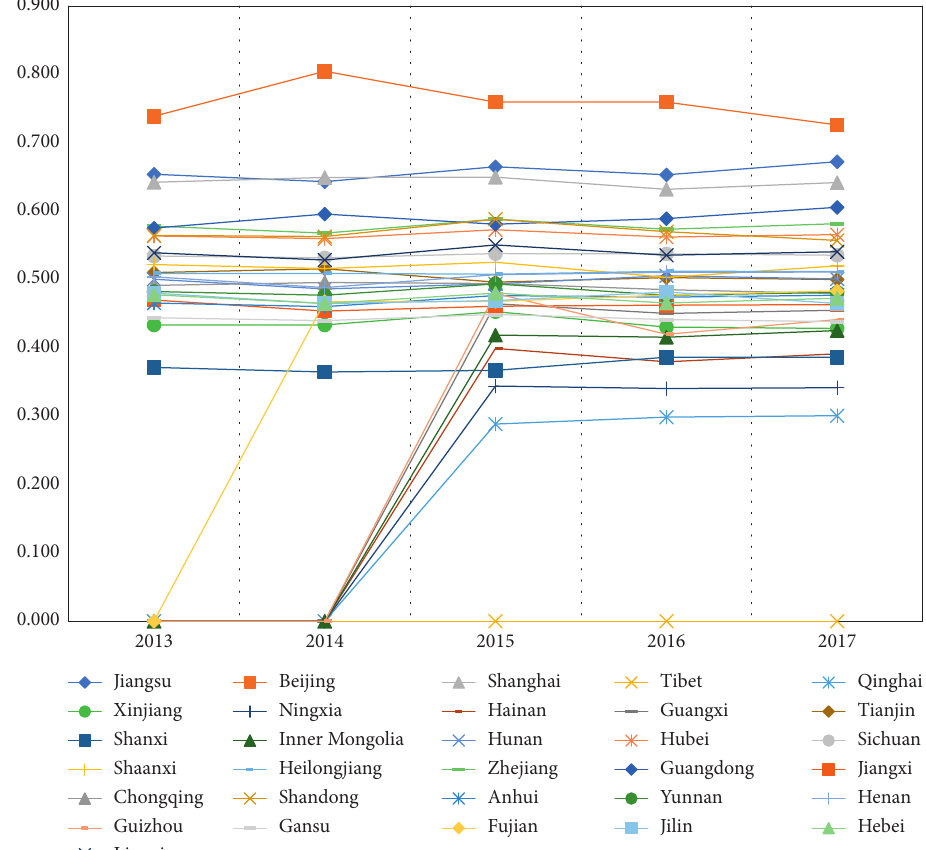
Figure 5: Temporal changes of